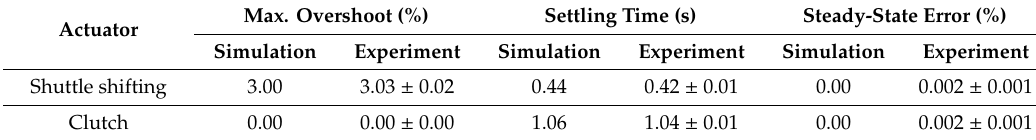
Figure 11. Comparison of simulation and component experiment results of ( a ) shuttle shifting actuator and ( b ) clutch actuator. Table 3. Response performance in simulation and experiment for shuttle shifting and clutch